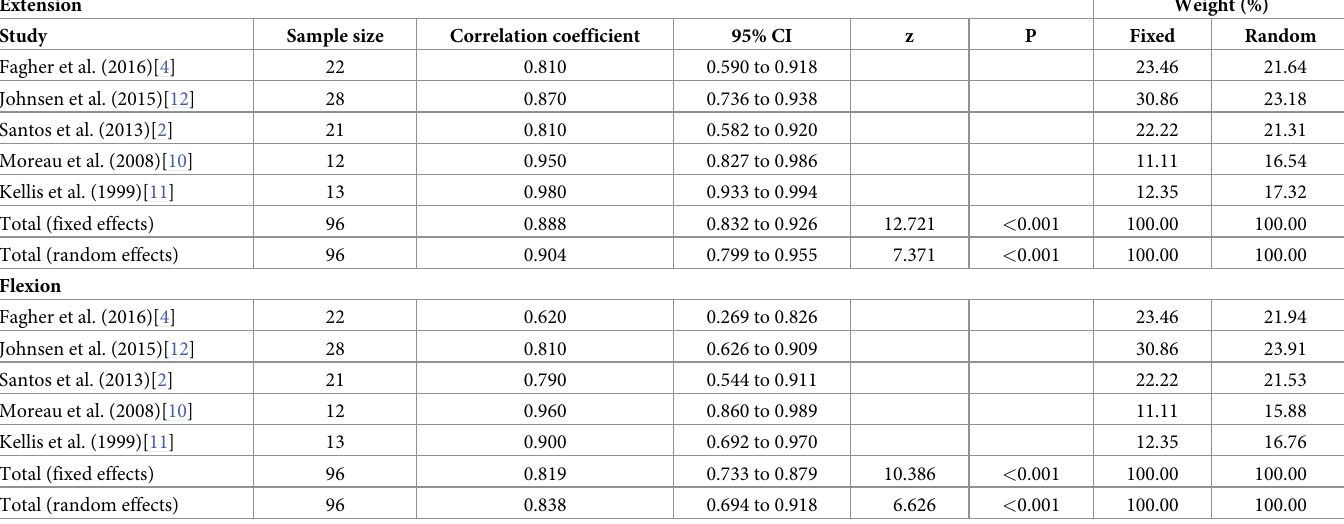
Table 6. Summary meta-analysis of reliability with confidence interval for extension and flexion of knee in children in concentric mode at 60˚/s.